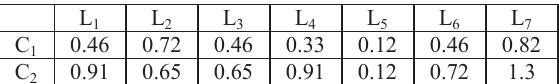
Fig 3. User-User resemblance matrix